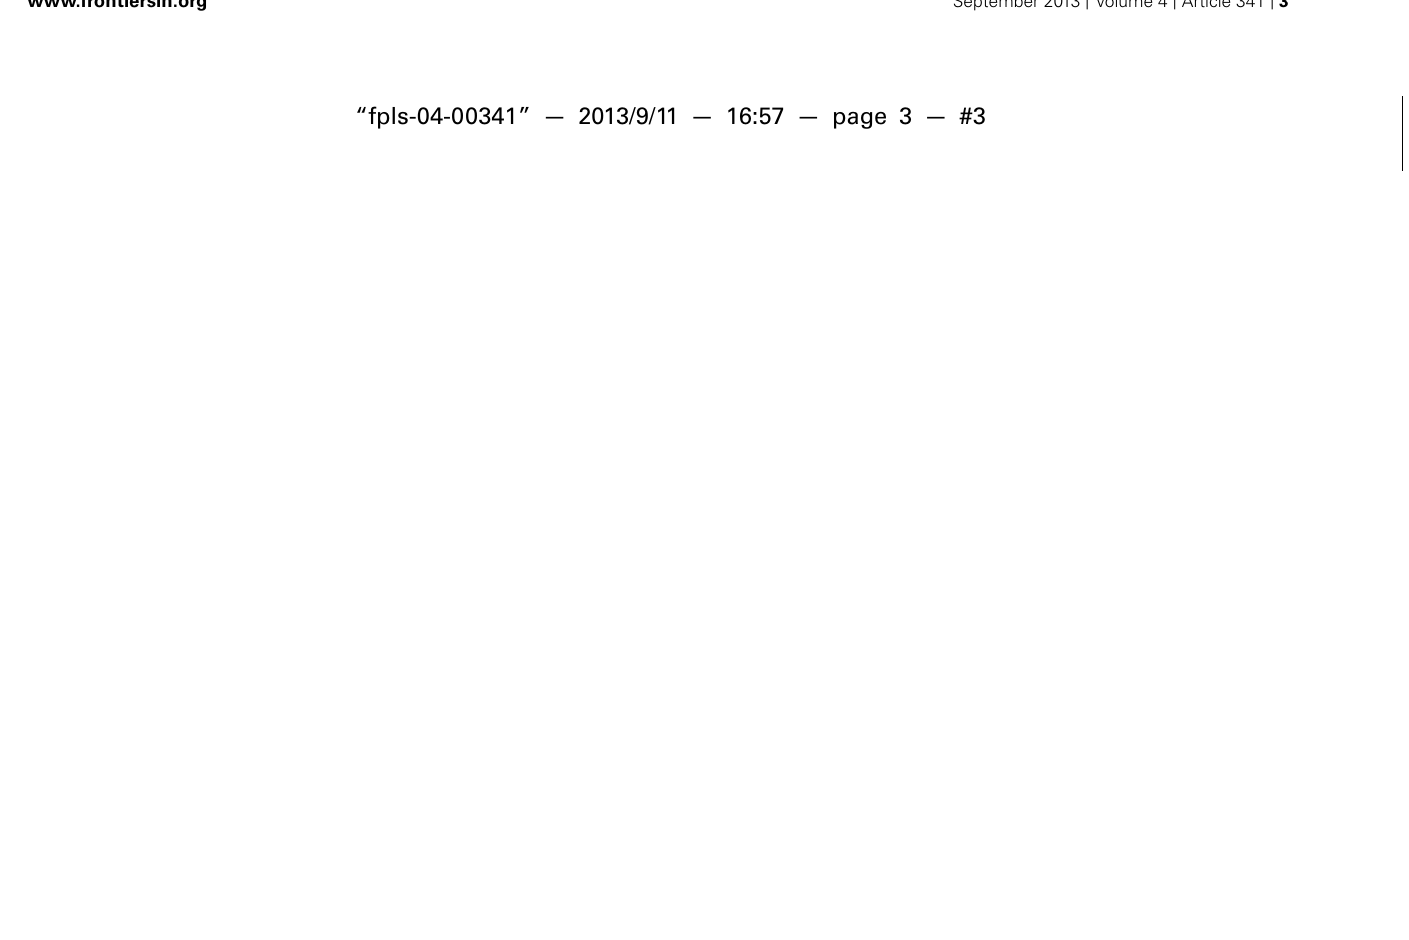
FIGURE 1 | Examples of interplays between SL and NO signaling in animal (A,B) and plant cells (C,D). (A) NO regulates Cer formation from sphingomyelin in a dose-dependent process. Low NO concentrations inhibit sphingomyelinase activity (SMase) leading to low Cer levels that are further degraded to sphingosine (Sph) by ceramidases. High NO concentrations stimulate SMase activities while inhibiting ceramidases, therefore leading to high Cer levels.This differential control of SMases by NO participates in Cer-dependent cell survival or death. (B) Cer formation indirectly triggers endothelial NOS (eNOS) activation and NO formation. Sphingosine-1P (S1P) is formed from Cer degradation and subsequent phosphorylation of Sph. S1P is externalized and perceived on the outer cell surface by specific